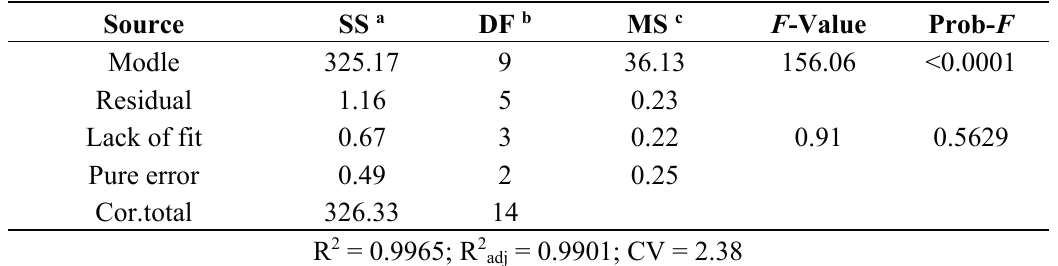
Table 2. Analysis of variance for the fitted quadratic polynomial model of purification of PPP.